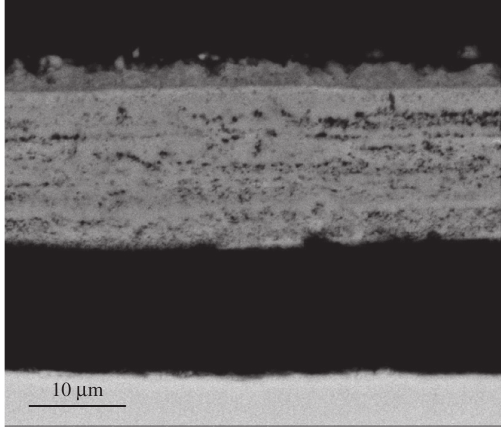
Figure 5: Micrograph (SEM/BEI) of a cross section of Ti-5Al-2.5Sn oxidized in air at 750°C for 24